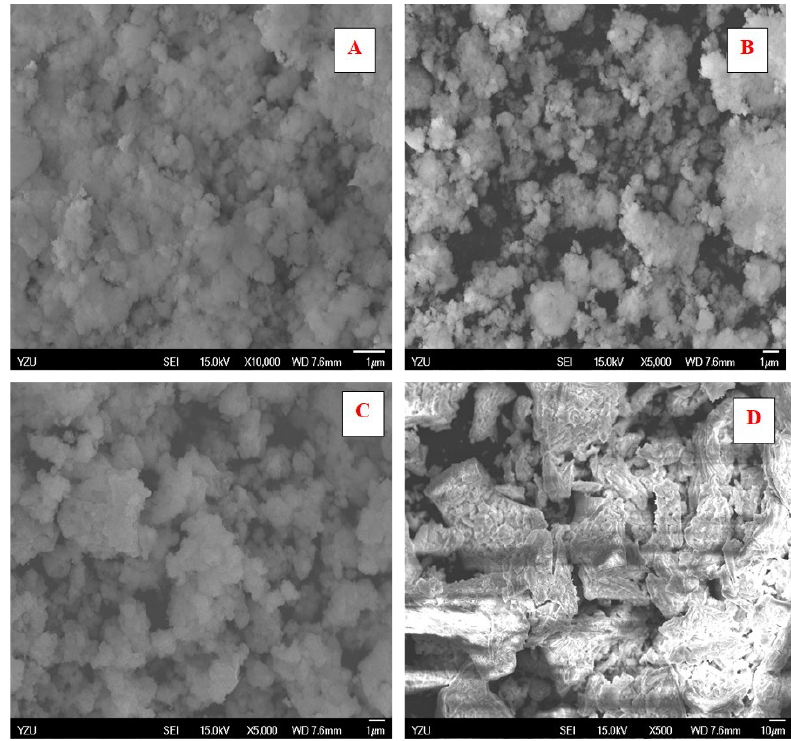
Figure 4. SEM profile of ( A ) Ash:MgO (1:1), ( B ) Ash:MgO (1:2), ( C ) Ash:MgO (1:3), and ( D ) Ash:MgO/ZrO 2